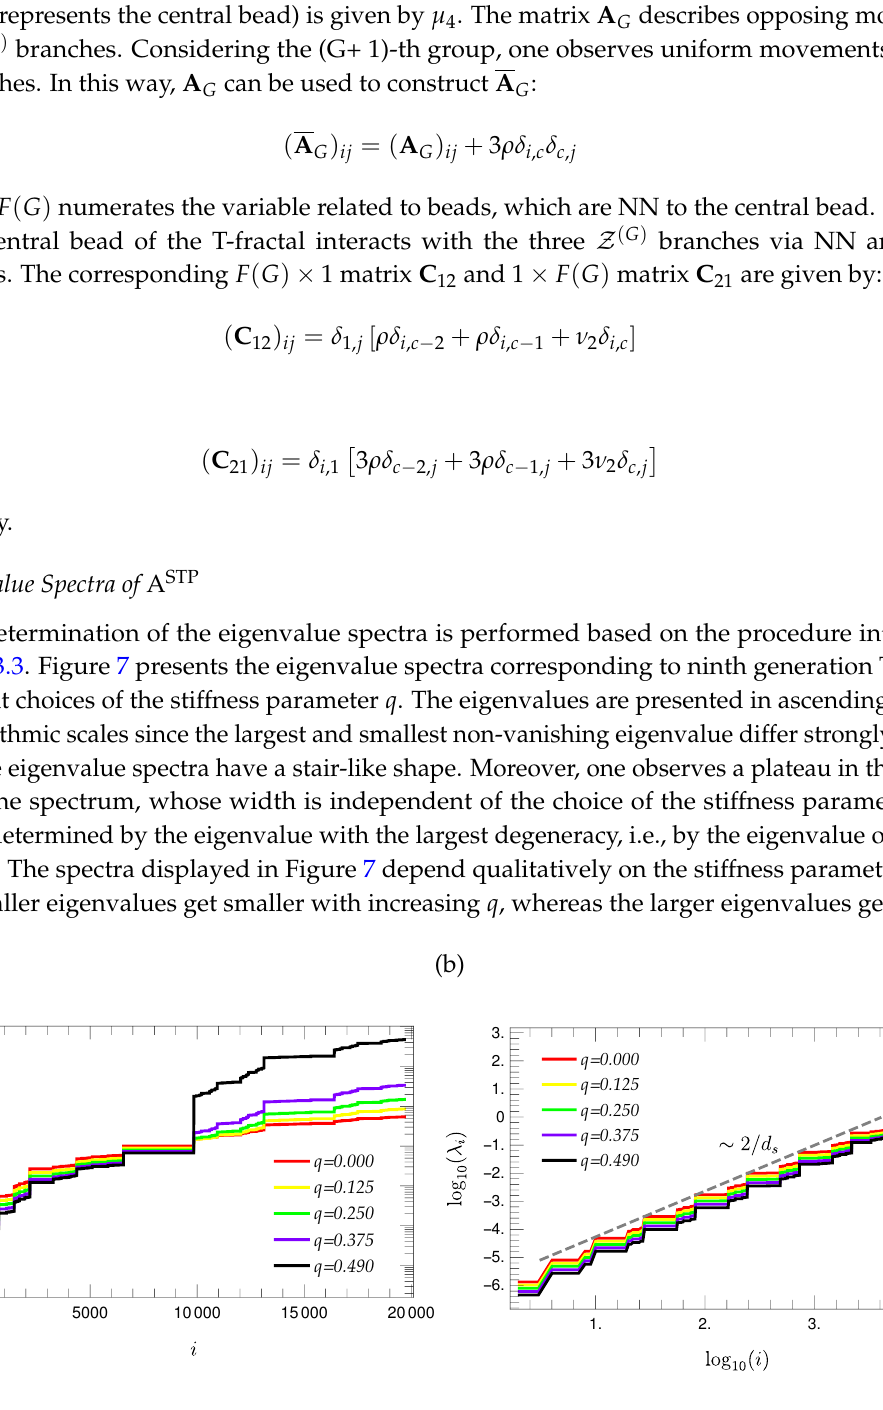
Figure 7. Eigenvalue spectra of G = 9 T-fractals plotted in semi-logarithmic (a) and in double logarithmic (b) scales for different values of the stiffness parameter q .